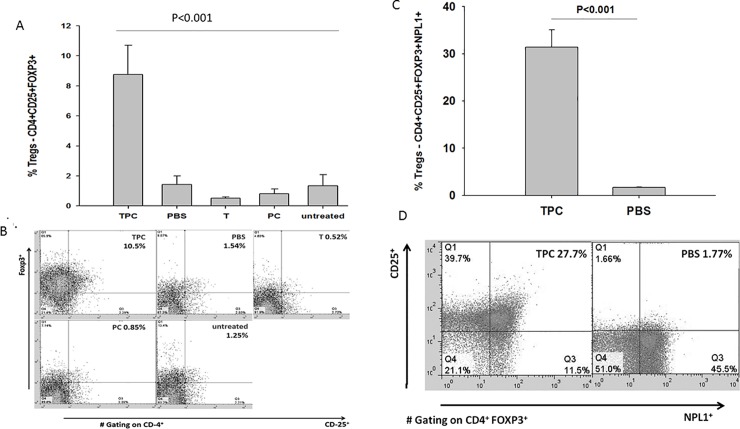
Increase in Treg cells in isolated splenocytes of TPC-treated CIA mice.[A] The data are presented as percentage of Treg cells -CD4+CD25+FOXP3+ expansion in isolated splenocytes of tuftsin- phosphorylcholine (TPC), PBS, tuftsin (T), phosphoryl choline (PC), and untreated CIA mice (n = 10). Values are the mean ± SD, P < 0.001. [B] Representative flow cytometry analyses of Treg cells -CD4+CD25+FOXP3+ (gated on CD4+) in isolated splenocytes derived from CIA mice treated with TPC, PBS, T and PC and untreated CIA mice. [C] The data are presented as percentage of Tregs -CD4+CD25+FOXP3+ neuropilin-1+ (NPN1+) expansion in isolated splenocytes of TPC and PBS treated mice (n = 10). Values are the mean ± SD, P < 0.001. [D] Representative flow cytometry analyses of Tregs -CD4+CD25+FOXP3+ neuropilin-1+ NPN1+ (gated on CD4+FOXP3+) in splenocytes derived from the TPC and PBS treated mice P < 0.001.